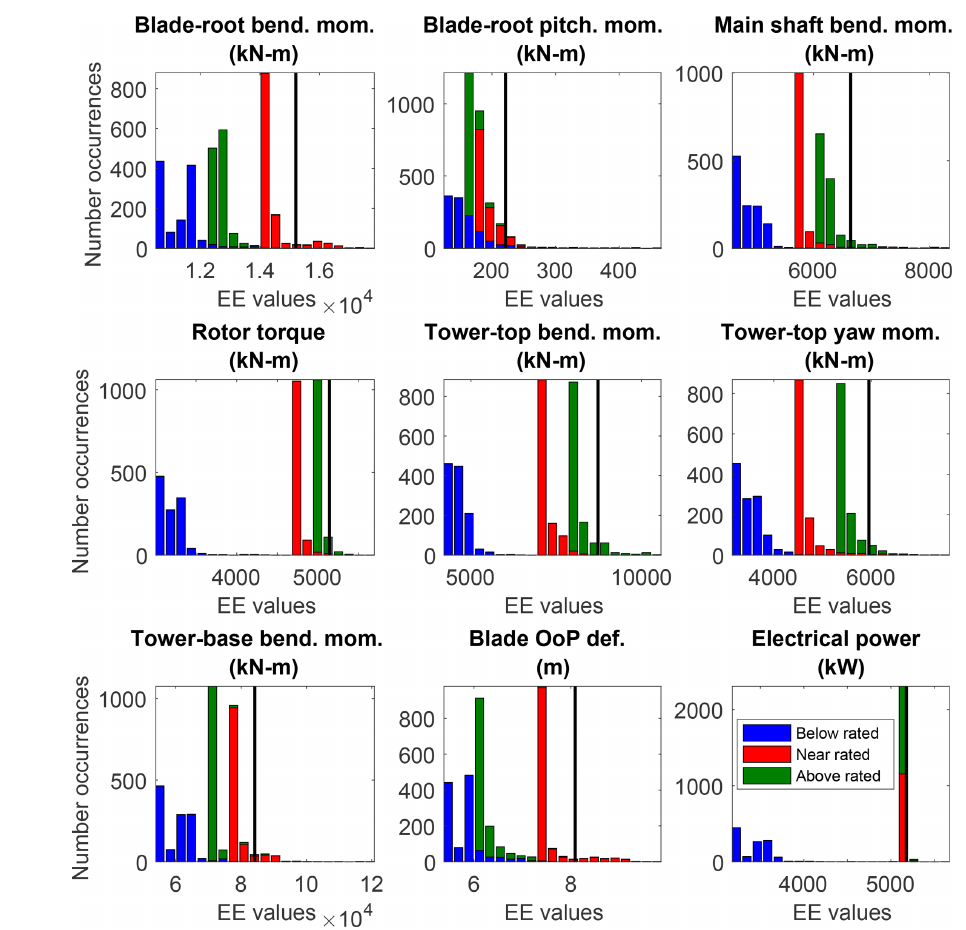
Figure 12. Stacked EE-value histograms of ultimate loads across all wind speed bins, input parameters, and simulation points for all QoIs. The black line represents the threshold by which outliers are counted for each QoI. Color indicates wind speed bin (blue is below-rated speed, red is near-rated speed, green is above-rated